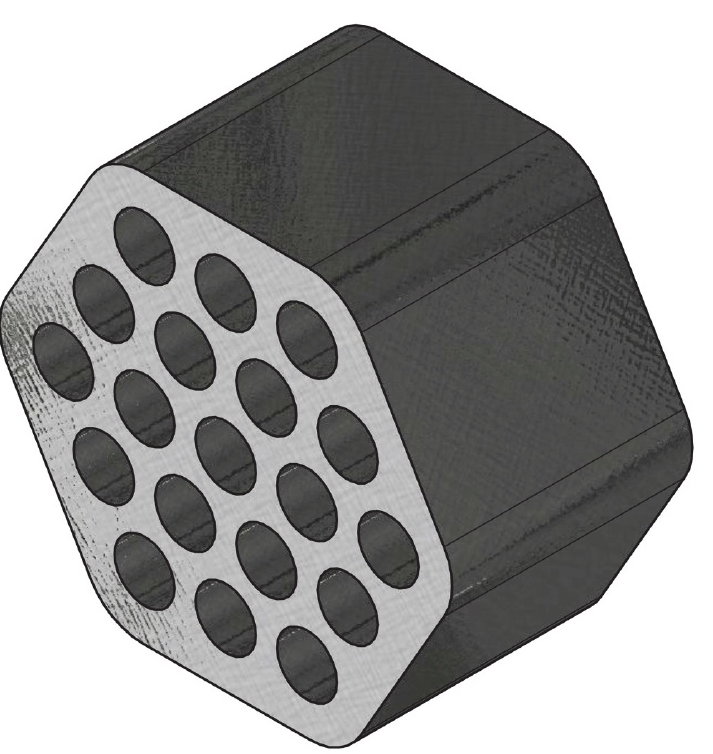
Figure 5. Isometric view of the SIRIUS-CAL fuel